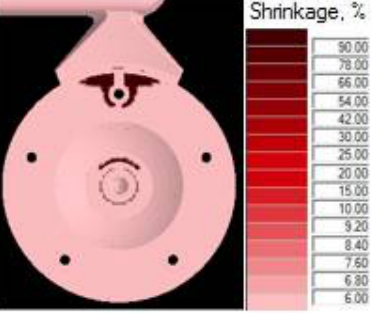
Figure 9. Distribution of defects for incorrect of cast forming—contractions 2.8%.